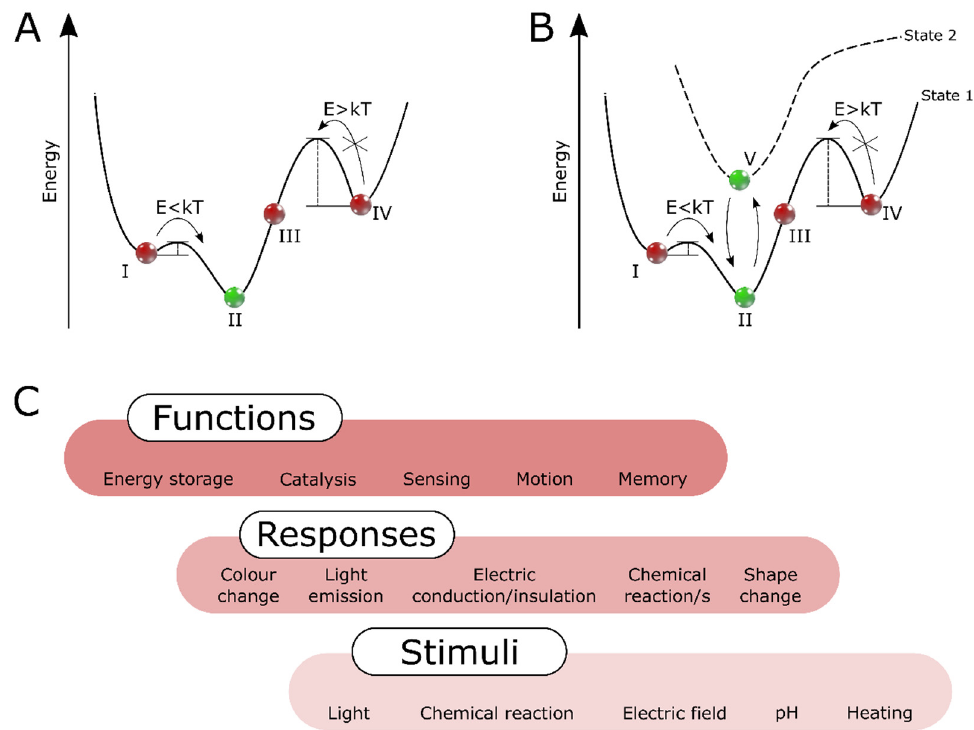
Figure 1. ( A ) Schematic representation of the energy diagram showing the possible energy states of a dynamic system and possible transitions between them. I. Metastable state. II. Equilibrium state, III. Out-of-equilibrium energy dissipative state. IV. Kinetically trapped metastable state. ( B ) Adaptive materials can also perform the transition between different equilibrium states. State 1 and State 2 refer to different state parameters in two different states. ( C ) Examples of the stimuli applied to 2D systems trigger responses that lead to the execution of tasks.